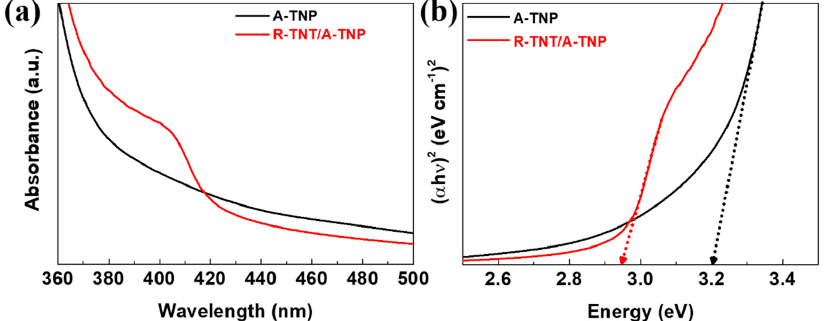
Figure 3. Light absorption capability and bandgap estimation for A-TNP and R-TNT/A-TNP: ( a ) UV-visible absorption spectra; ( b ) Tauc plots for A-TNP and R-TNT/A-TNP.